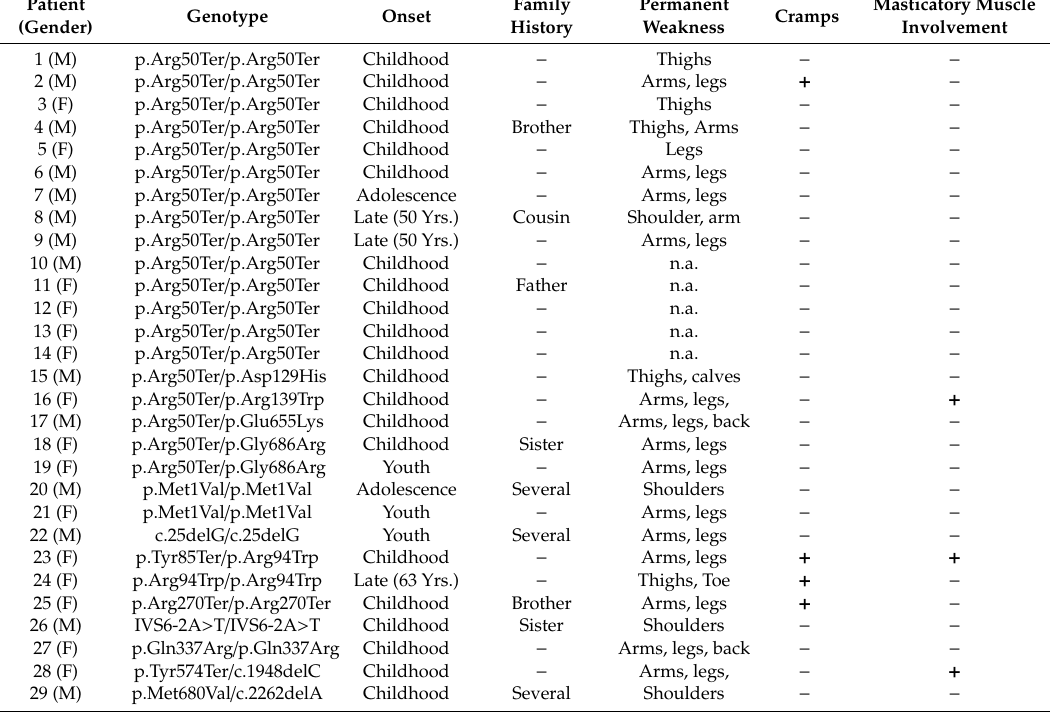
Table 1. Genotype and clinical data of patients with permanent